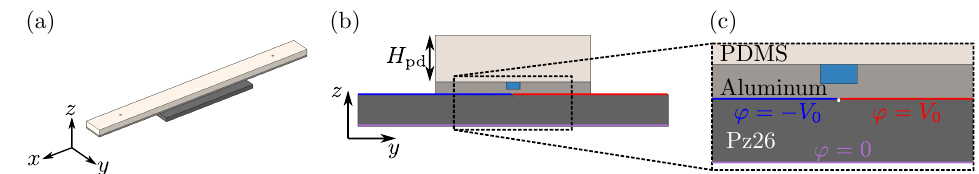
Figure 4. ( a ) 3D sketch drawn to scale of the proposed device driven by an anti-symmetric ac voltage. ( b ) The vertical cross section showing the thickness H pd of the PDMS cover. ( c ) Zoom-in on the water-filled microchannel showing the PDMS cover, the aluminum base, the Pz26 transducer, and its 9-µm-thick silver electrodes, with ground on the bottom electrode (purple) and anti-symmetric ac voltage positive/negative (blue/red) applied to the split top